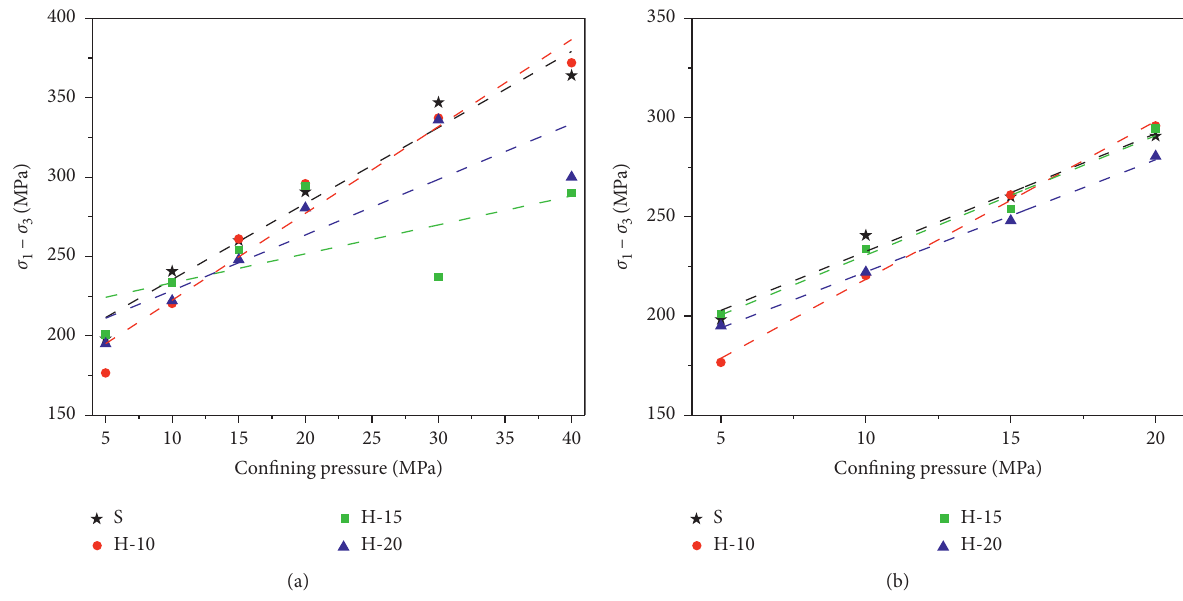
Figure 8: Fitting curves of the confining pressure and the deviator stress of specimens with different pore sizes. (a) Fitting curves under confining pressures (5 ∼ 40 MPa). (b) Fitting curves under four different confining pressures (5 ∼ 20